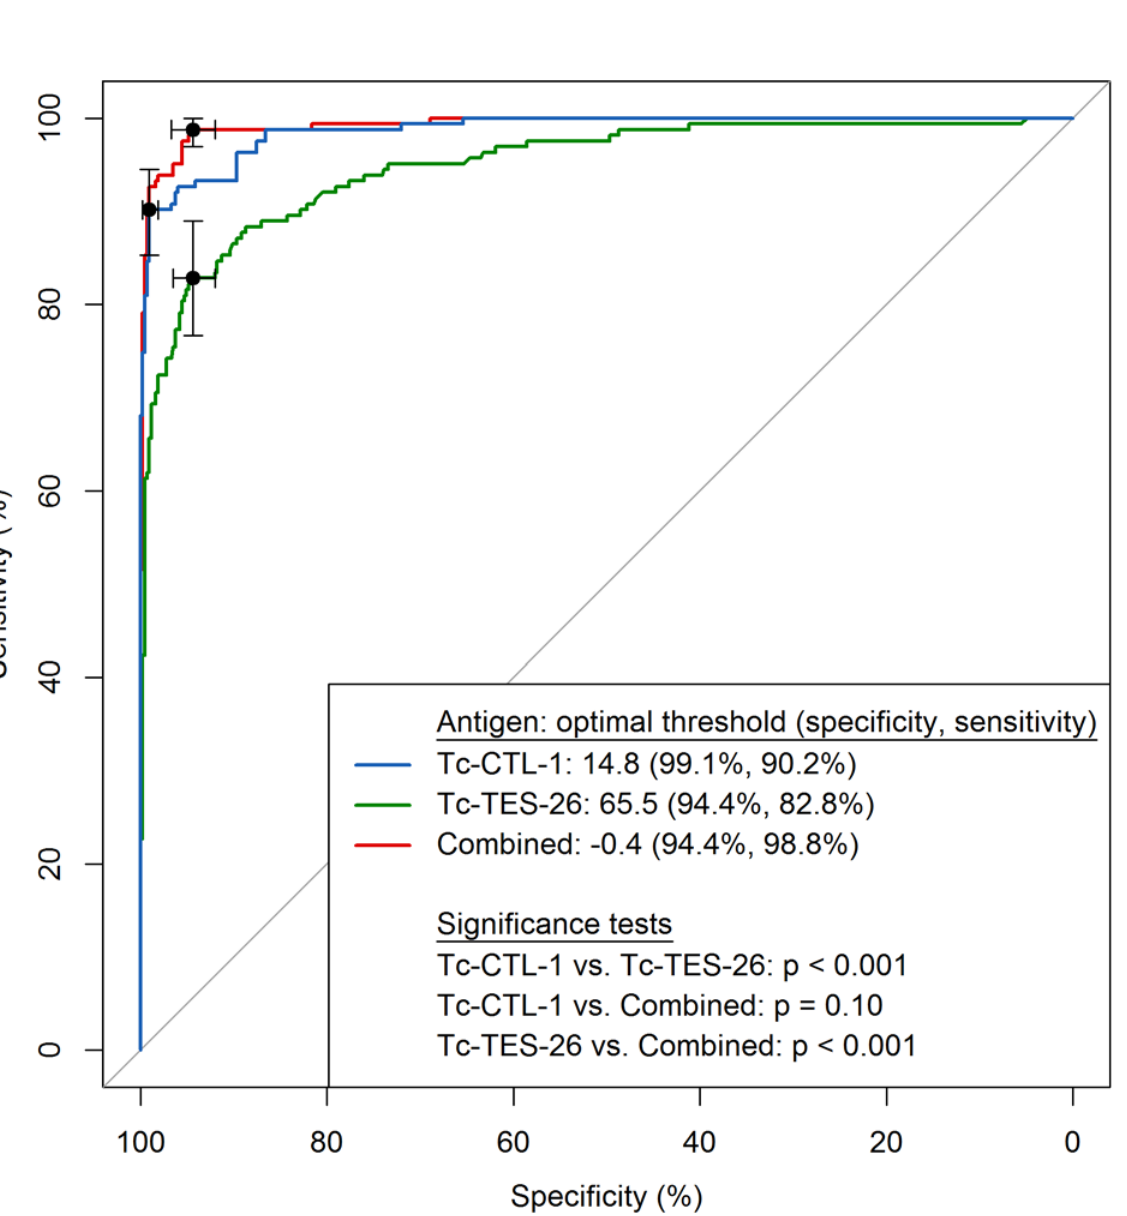
Fig 2. Purity and antigenicity of purified recombinant proteins. SDS-PAGE of the three recombinant proteins. A. Tc-CTL-1; B. Tc-TES-26; C. Tc-MUC-3. The recombinant protein samples at a concentration of: 1 – 6.25 ng/mm; 2 – 3.125 ng/mm; 3 – 1.6 ng/mm, and 4 – 0.8 ng/mm was treated with SDS and heated at 65°C for 15 minutes, separated and analyzed using SDS gel electrophoresis and western blotting. Two gels were transferred to nitrocellulose membranes and probed with a strong EIA positive Toxocara human sera pool, a negative human serum sample diluted 1:100 in PBS/Tween 0.3%/5% milk, and one gel was incubated with protein staining, Colloidal Gold Total Protein Stain (Bio-Rad, Cat. # 170 – 6527). M = Precision Plus Protein Dual Xtra Standards (Biorad, Cat. #161 – 0377)